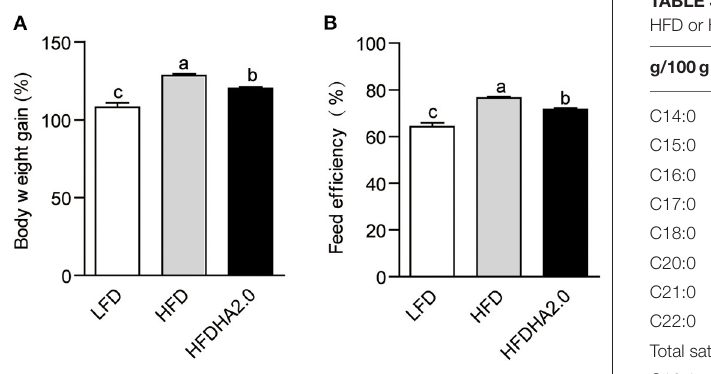
FIGURE 1 | The effects of DHA supplementation on growth and feed efficiency in zebrafish. (A) Body weight gain and (B) feed efficiency of LFD, HFD, or HFDHA2.0-fed zebrafish. Values are means ± SEMs ( n = three biological replicates). The mean values without a common letter are significantly different, p < 0.05. LFD, low-fat diet; HFD, high-fat diet; HFDHA2.0, 2% DHA-supplemented HFD.